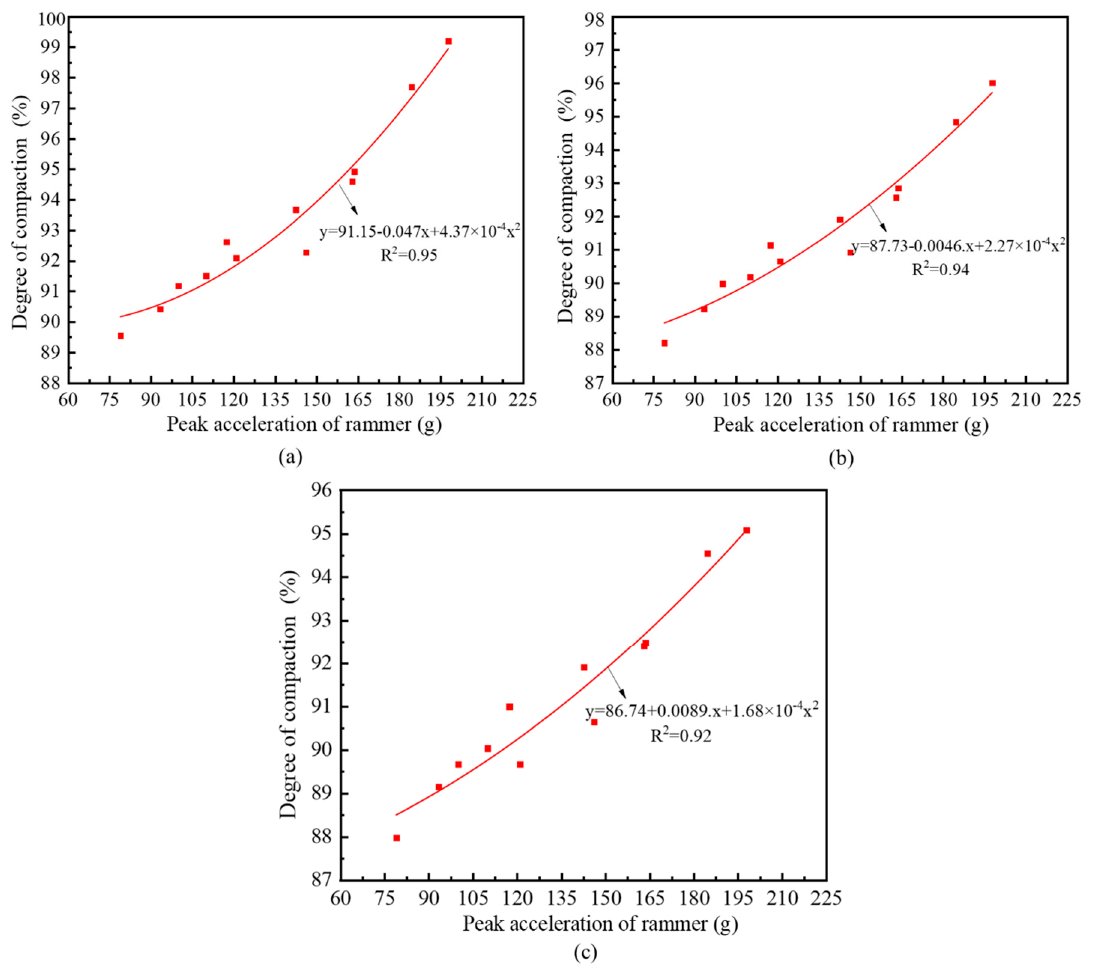
Figure 12. Fitting of layered compactness and peak acceleration in effective depth range: ( a ) 0–30 cm; ( b ) 30–60 cm; ( c ) 60–90 cm.